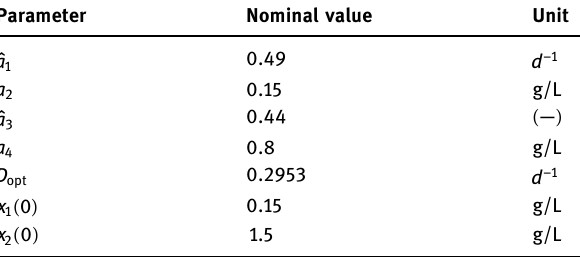
Table 2: Nominal parameter value for continuous and mixotrophic Spirulina platensis culture